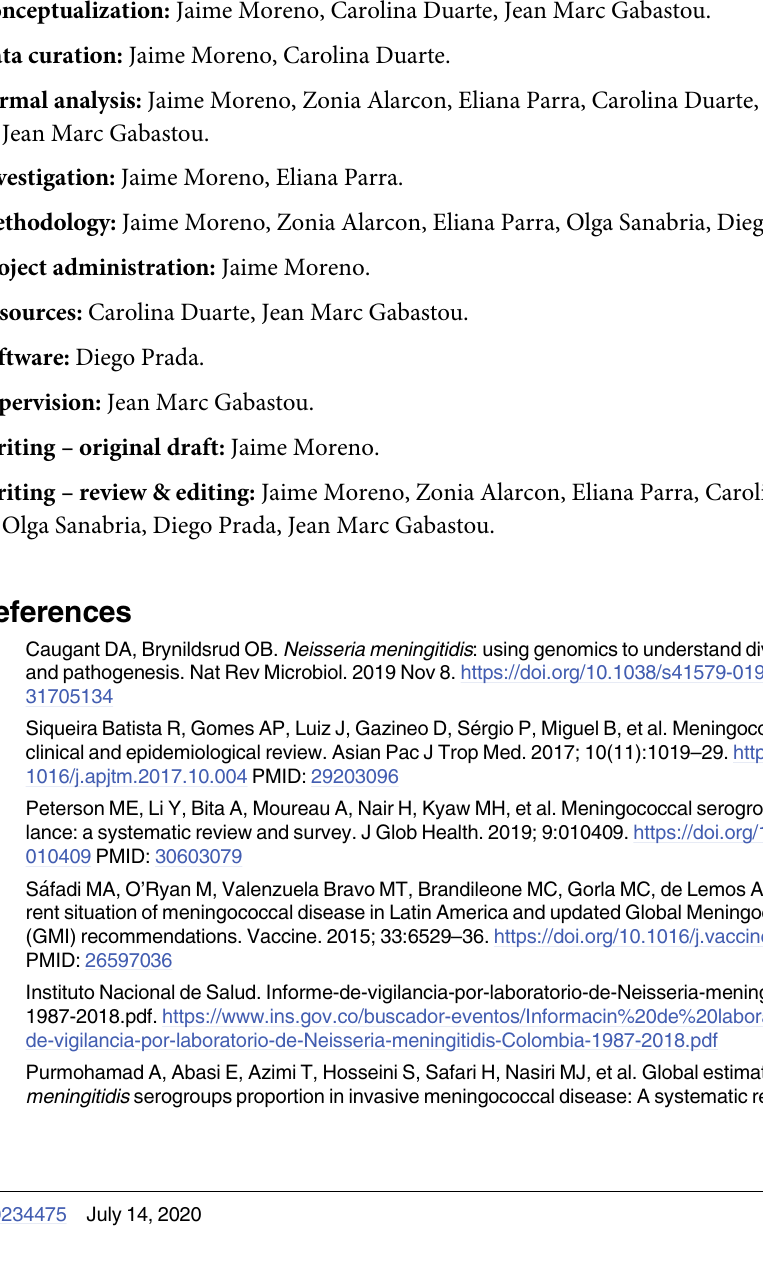
S1 Fig. Dendrogram of invasive N . meningitidis isolates from 2013–2016. S1 Table. N . meningitis clonal complex distribution by serogroup for Colombia, 2013–